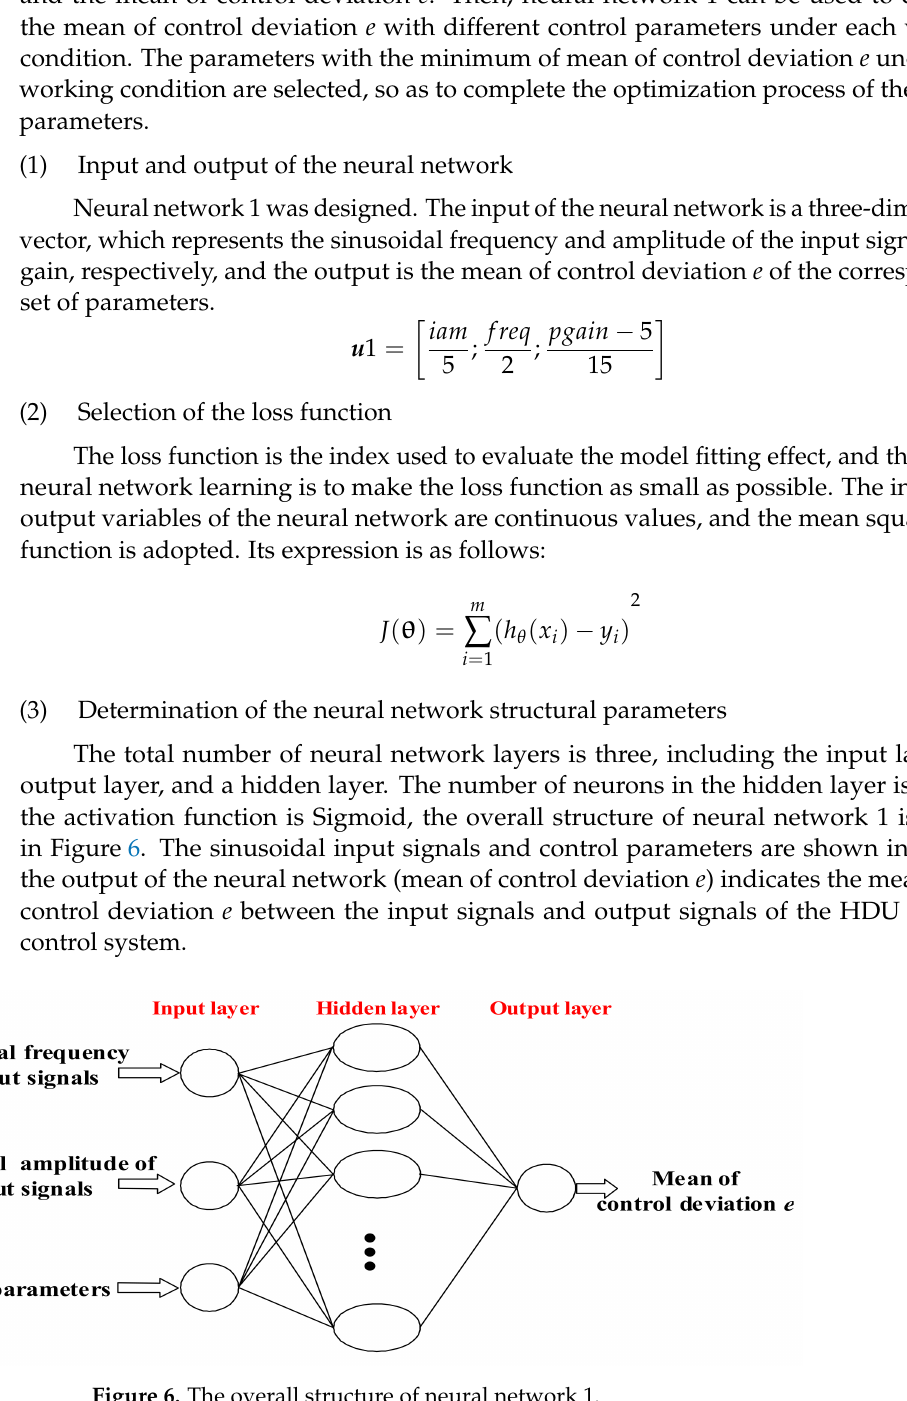
Figure 6. The overall structure of neural network